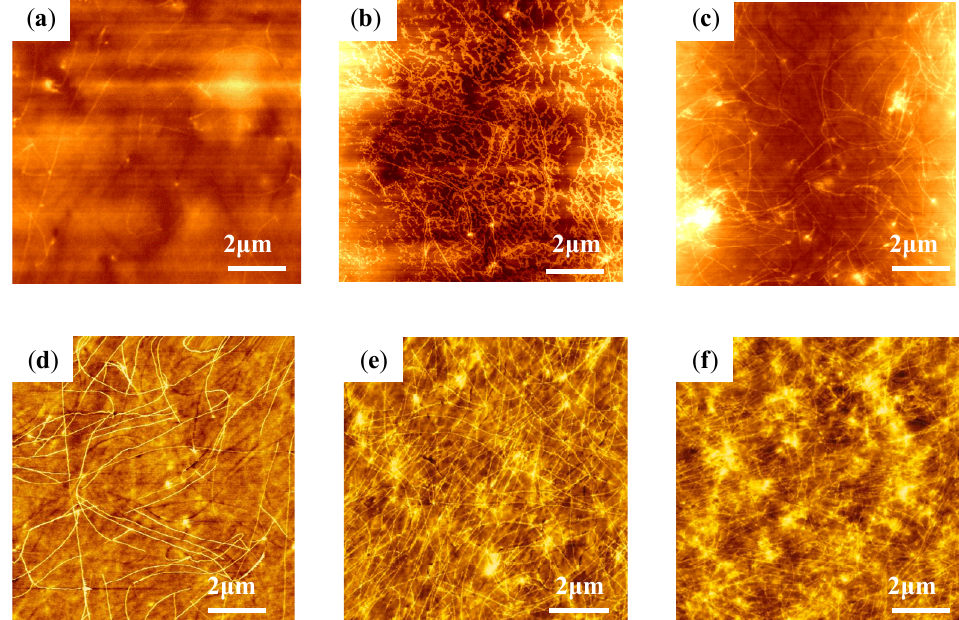
Figure 1. SFM images of P3HT/PMMA nanofiber composite films made with P3HT/PMMA in weight ratios of ( a ) 0.3:99.7; ( b ) 1:99; ( c ) 3:97; ( d ) 5:95; ( e ) 10:90; and ( f ) 20:80.